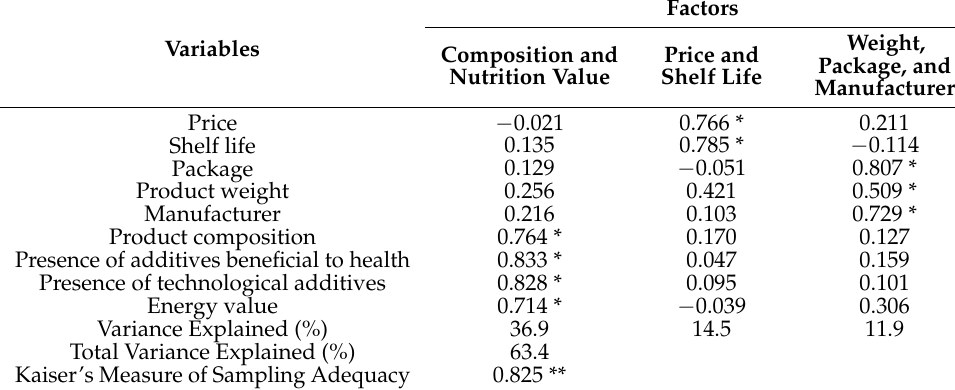
Table 1. Factor-loading matrix for reading food labels ( N =